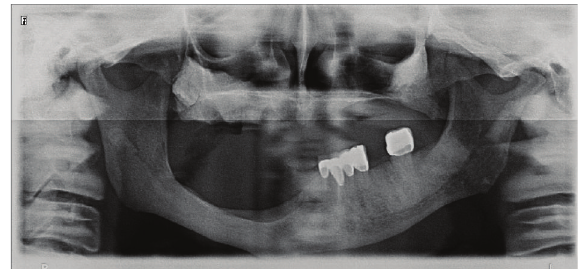
Figure 8: Panoramic radiography of patient at 1-year follow-up visit in